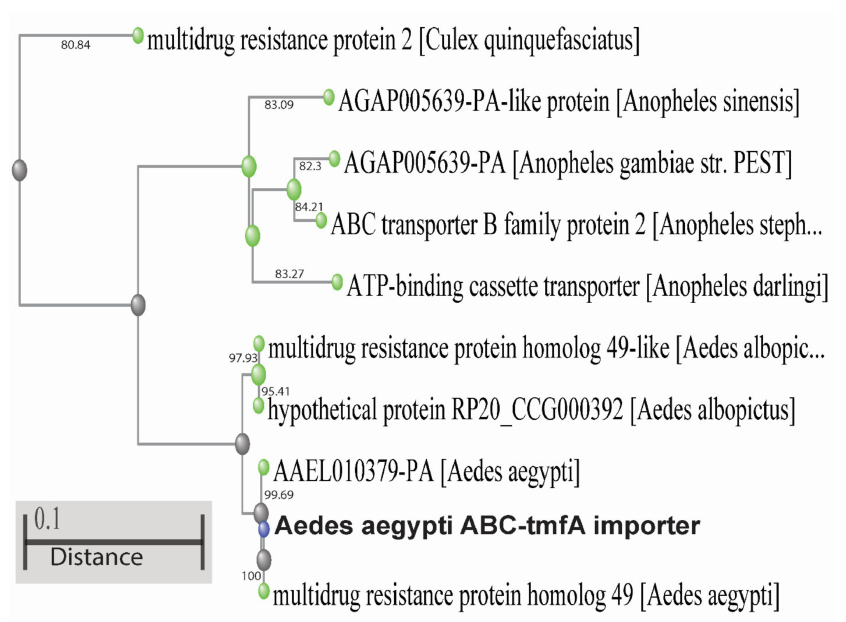
Figure 5. A phylogenetic tree of Aea ABC-TMOF receptor using sequence homology (80–100%). Several sequences from Ae. aegypti , Ae. albopictus , Anoheles darlingi, Anopheles stephensi, Anopheles gambiae, Anopheles sinensis and Culex quinquefasciatus show sequence similarities to the Aea ABC-TMOF receptor. Using Blast pairwise alignments (blast.ncbi.nlm.nih.gov) the distance between the sequences is shown as a bar on the bottom left corner.